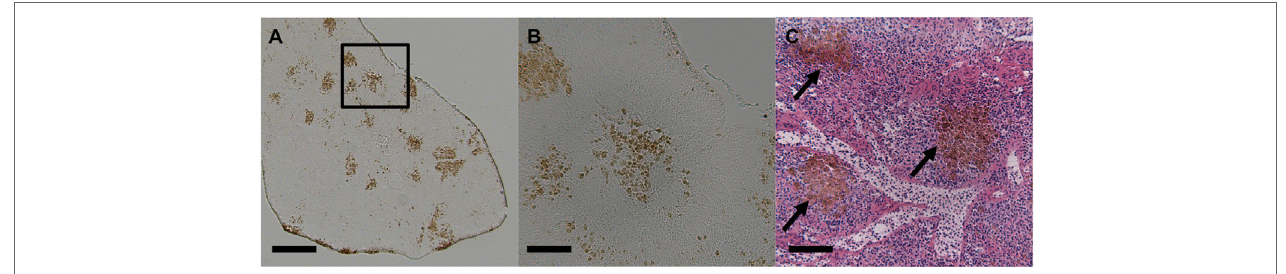
FigURe 1 | Light micrographs of stickleback ( Gasterosteus aculeatus ) splenic melanomacrophage centers. (A) Unstained spleen at 50 × . Scale bar equals 250 µm. Box outlines magnified section in panel (B) . (B) Unstained spleen at 200 × . Scale bar equals 62.5 µm. (C) H&E-stained spleen at 200 × , and black arrows indicate MMCs. Scale bar equals 62.5